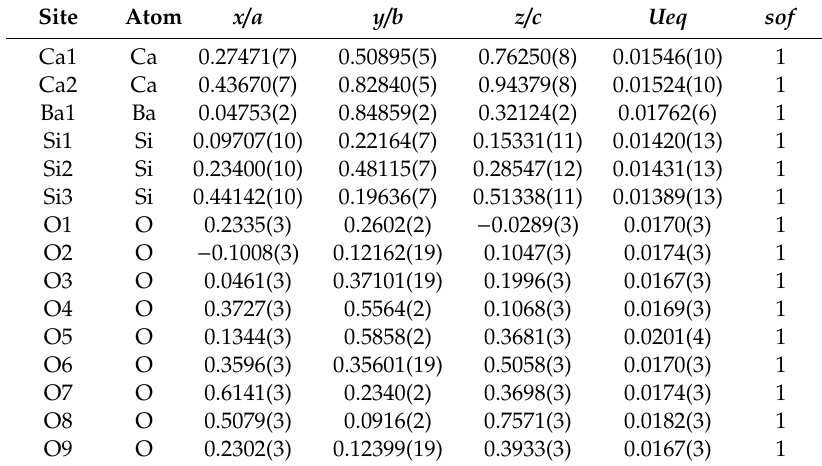
Table 2. Atom coordinates, U eq (Å 2 ) values for walstromite.